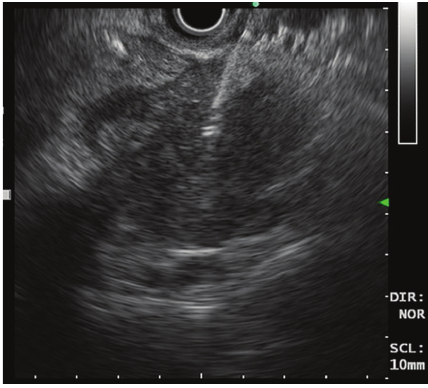
Figure 6: EUS-guided FNA of the pancreatic mass.